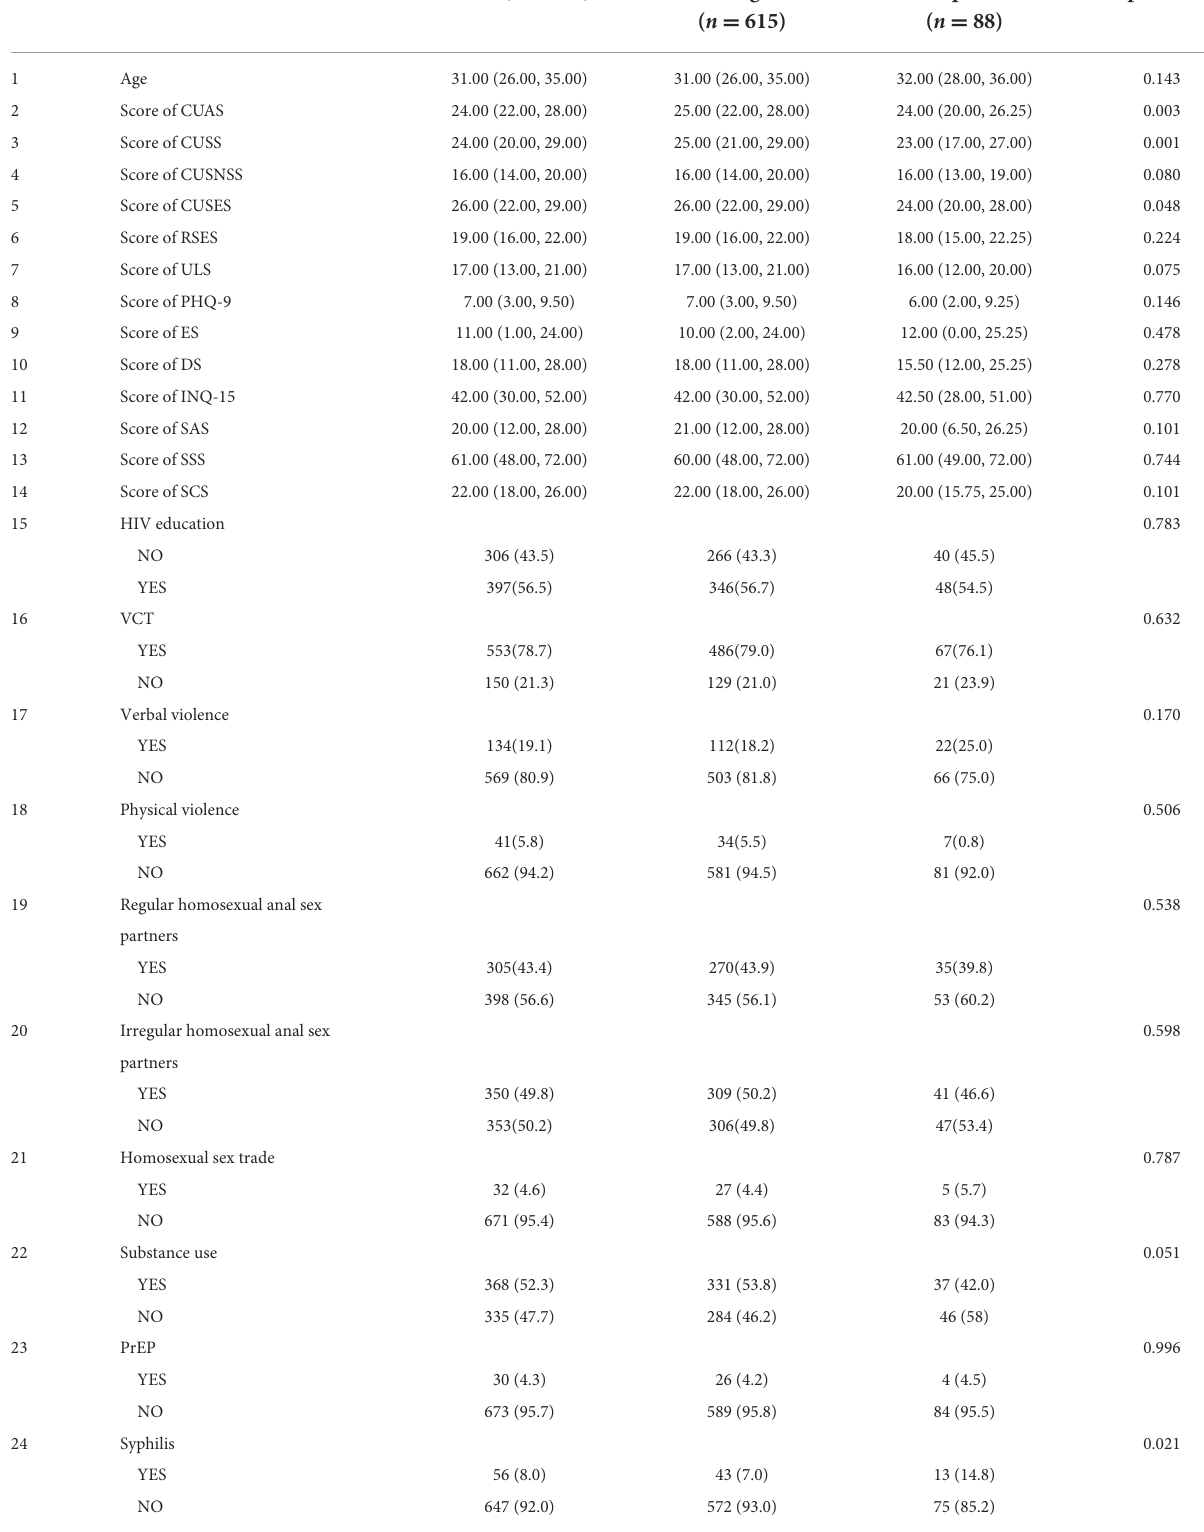
TABLE 1 Characteristics of the